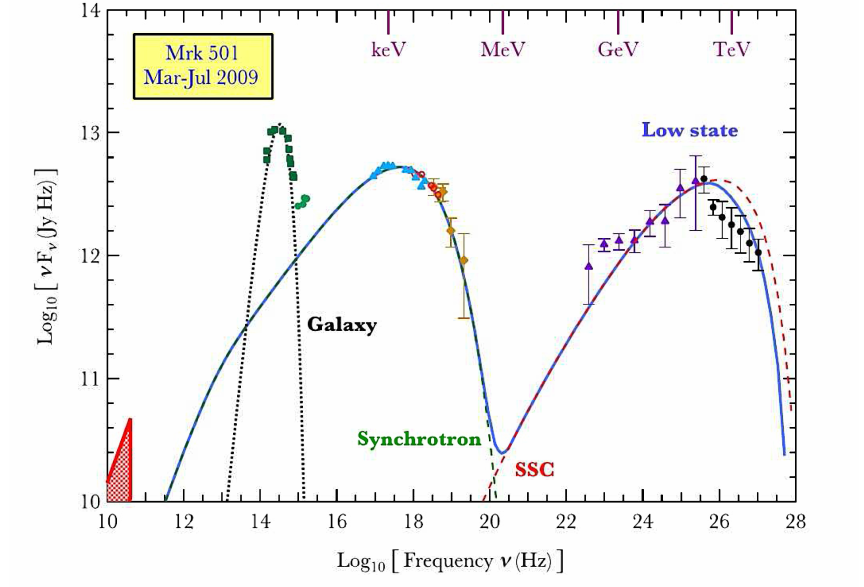
Figure 1. Fit to the spectral energy distribution (SED) of the high-frequency peaked BL Lac object (HBL) Mrk 501 (data from [22]), with η 1 = 100 and α = 1.5. From